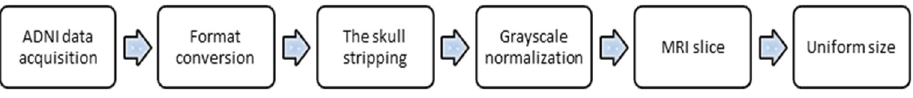
Figure 6. Preprocessing flow chart.